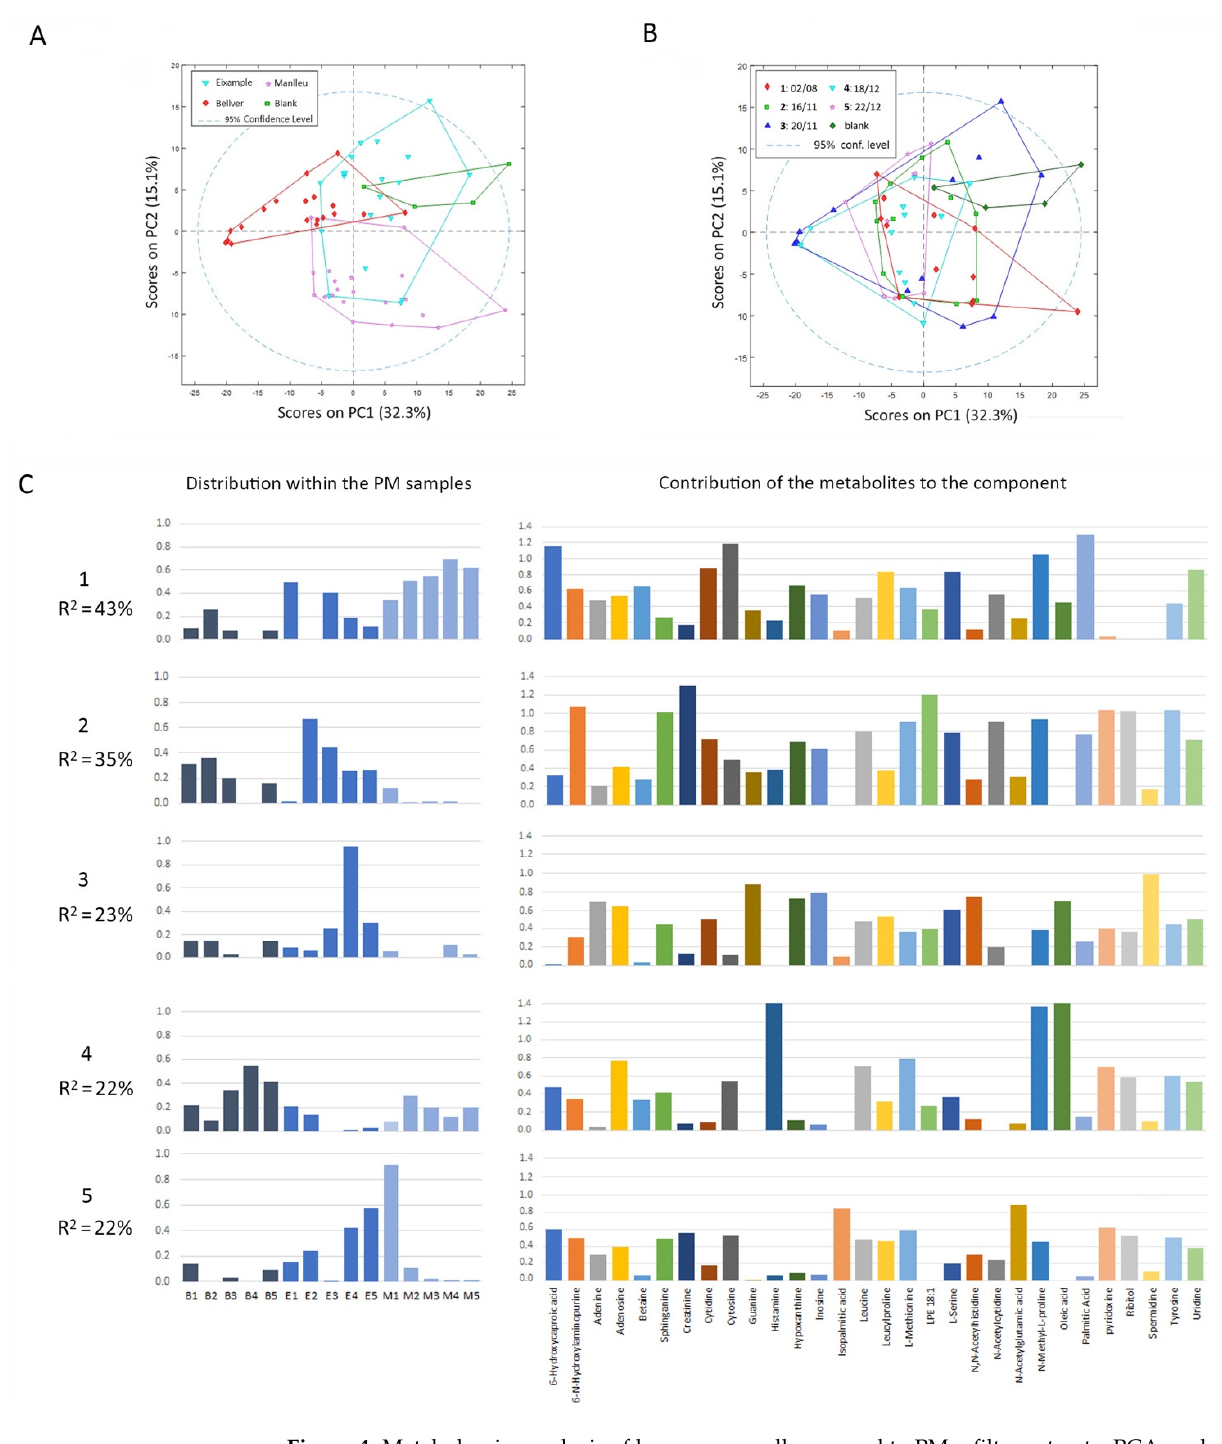
Figure 4. Metabolomics analysis of lung cancer cells exposed to PM 10 filter extracts. PCA analysis of lipid areas matrix considering ( A ) different locations or ( B ) different collection dates. ( C ) MCR-ALS resolved components of metabolomics data. For each component, the left bar plot represents the sample contribution to the component. The right bar plot indicates the metabolite profile of each resolved component. Different color bars in these plots are only meant to facilitate the vertical correspondence to the x -axis in all the plots.